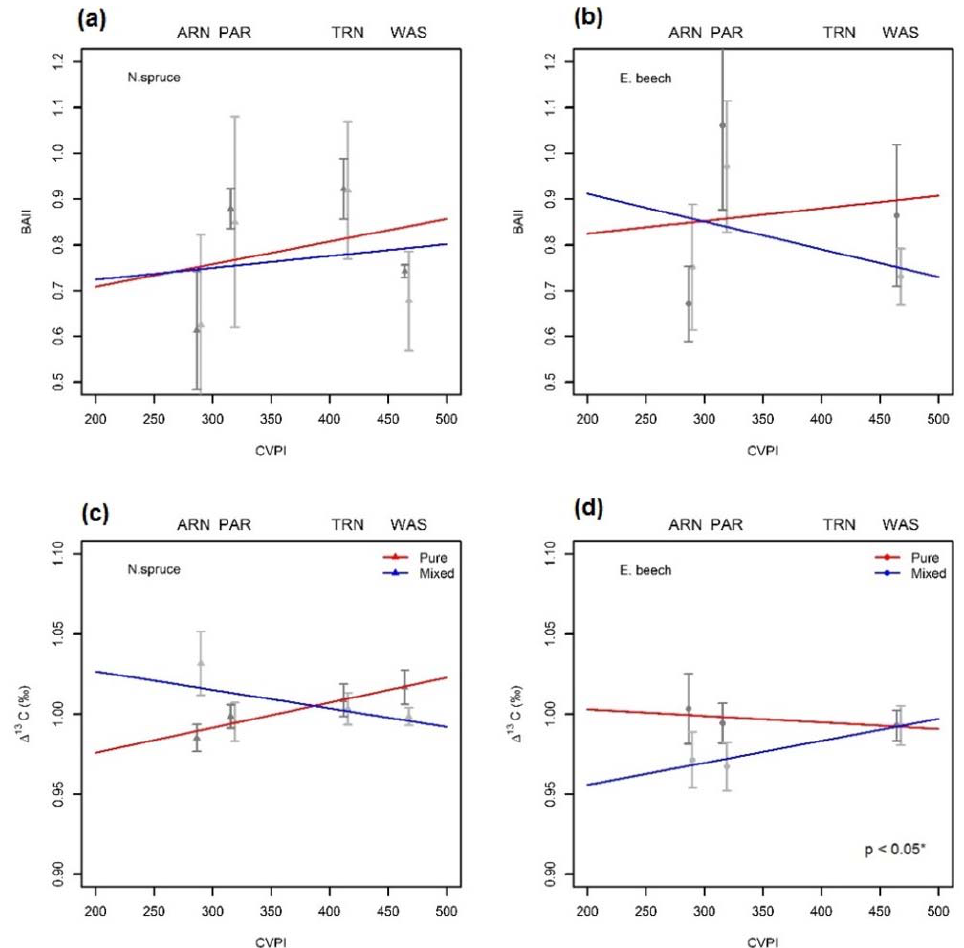
Figure A2. Linear mixed effect model of species and sites relative to the drought period in 2003 for the resilience of spruce and beech of BAII ( a , b ) and Δ 13 C ( c , d ) in monospecific or mixed environments along the gradient represented by Paterson ‐ index (CVPI).